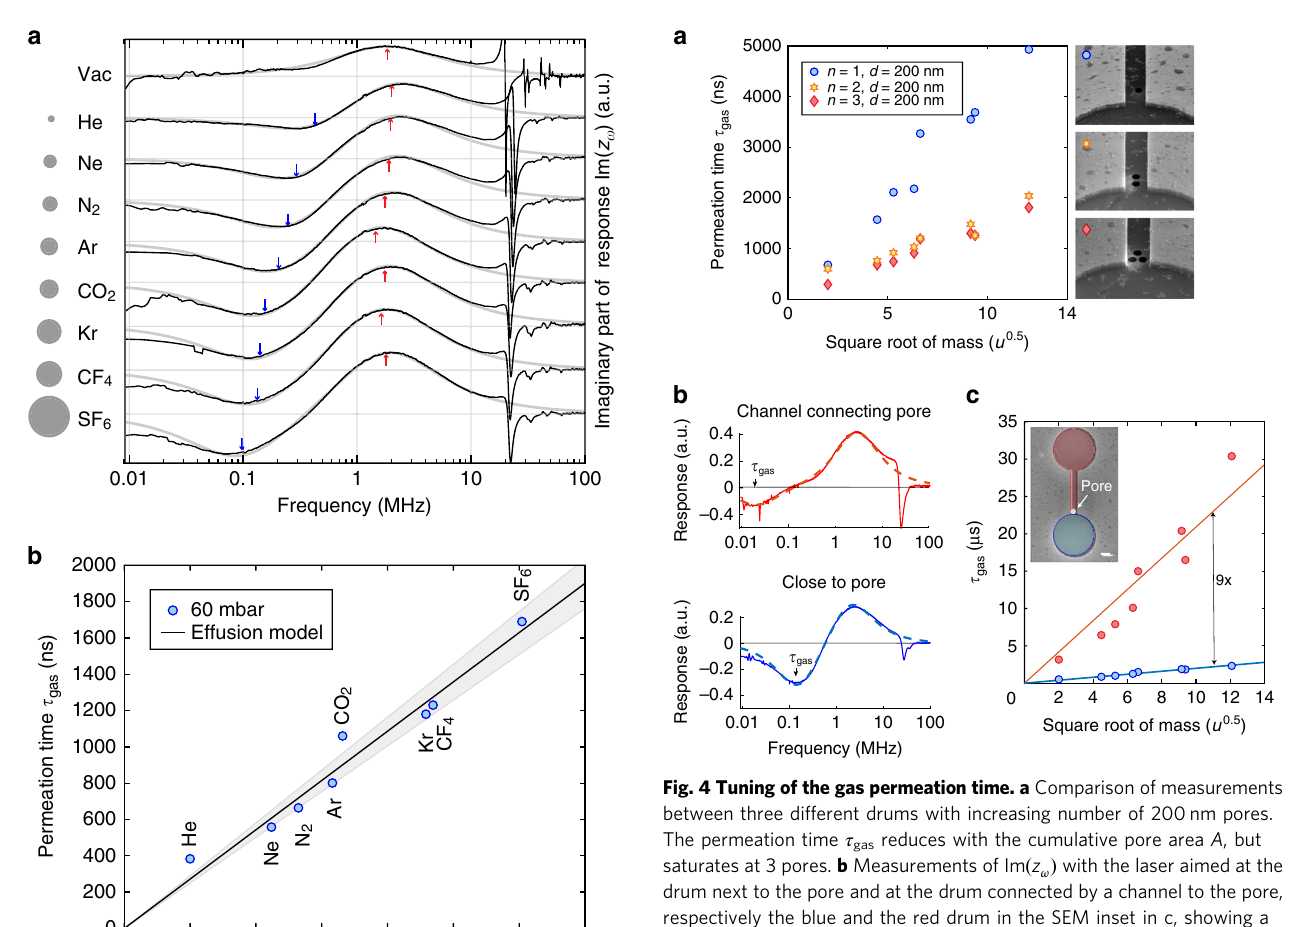
paragraph. The pore placement in the channel and mechanical permeation time.